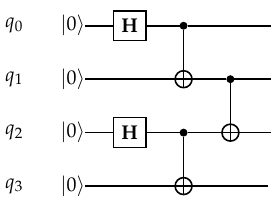
Figure 14. Local update circuit made of two qubits.